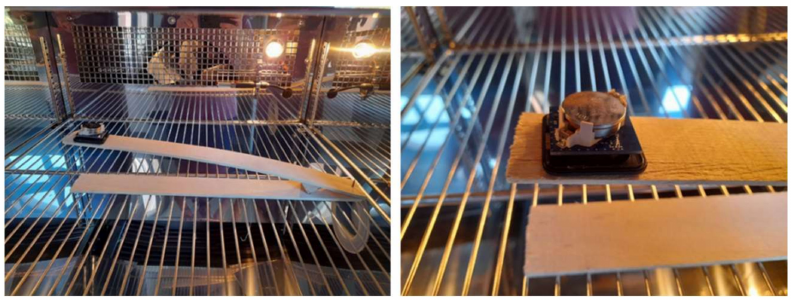
Figure 10. Sensor mounted on the cantilever in the climatic chamber.